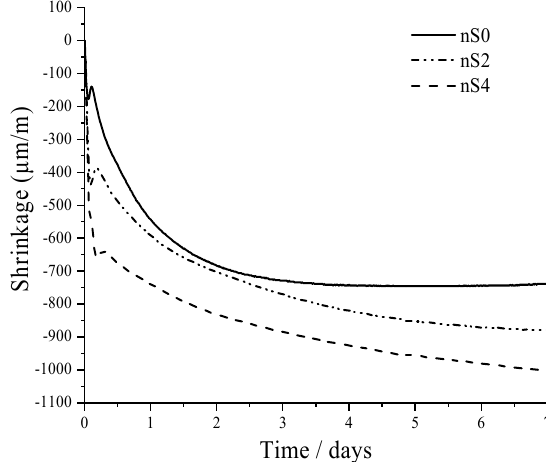
Figure 4. Autogenous shrinkages of UHSCs cast for 7 days.